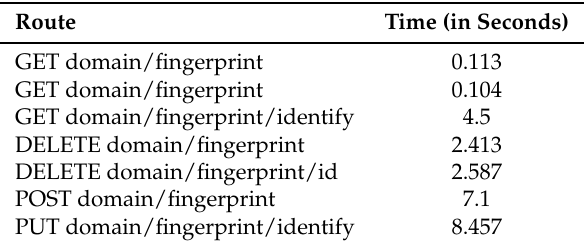
Table 2. Response time